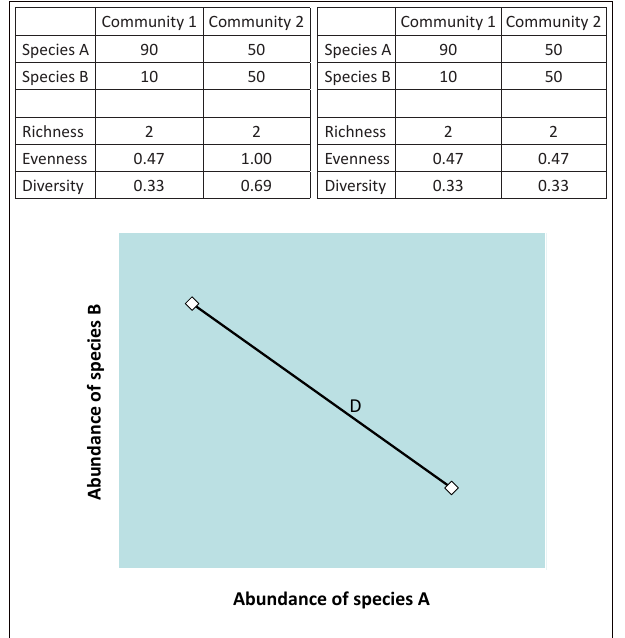
FIGURE 5: Illustration of two scenarios of communities that differ and how simple measures can distinguish communities in some instances, but not so in other instances. To overcome this, we propose the use of dissimilarity measures such as an Euclidean distance ( D ) illustrated here. of observed versus expected species presence at sample sites as indicators of ecosystem health and (2) a multivariate approach to evaluate the response of biological communities to management-induced changes in